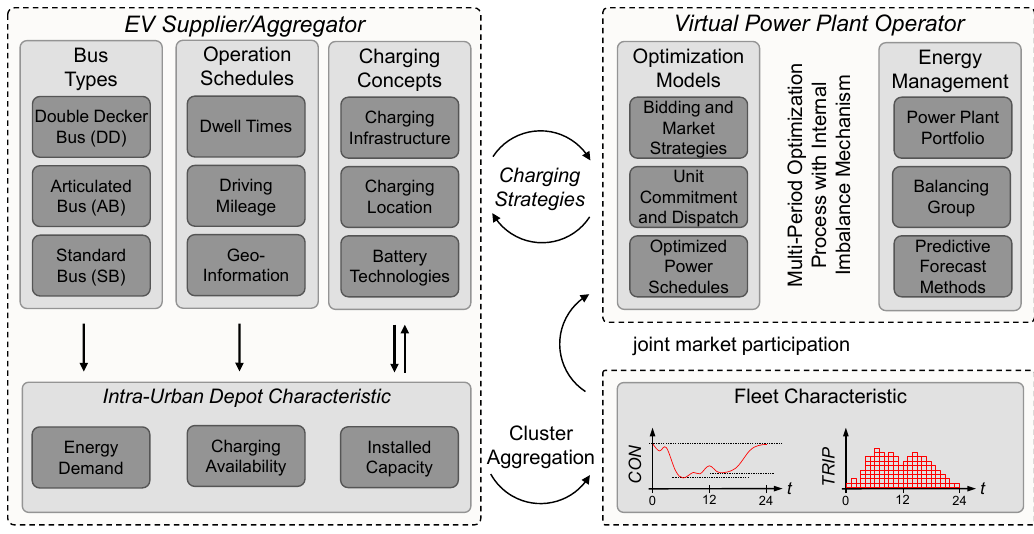
Figure 1. Framework conditions for the integration of electric bus fleets in the operation scheme of the EVS/A and VPP